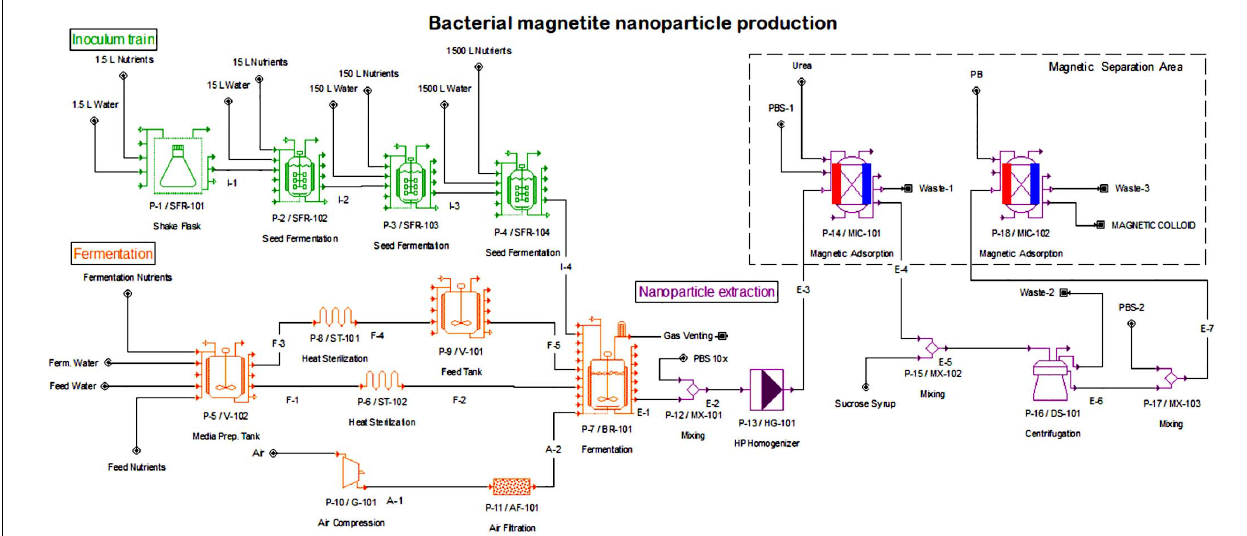
FIGURE 3 | Process flowsheet for the biomanufacturing of BMNs. The flowsheet depicts unit operations and material flows simulated in this work. The overall process is divided into three sections: the inoculum preparation train (in green) with four sequential scale-up steps, 3L (P-1), 30L (P-2), 300L (P-3), and 3000L (P-4), the fermentation (P-7), including media preparation (P-5), sterilization (P-6 and P-8), storage (P-9), air compression (P-10) and filtration (P-11) (in orange) and the downstream BMN extraction, including operations for cell lysis (P-12 and P-13), centrifugation (P-15 and P-16), and magnetic separation (P-14, P-17, and P-18) (in purple).